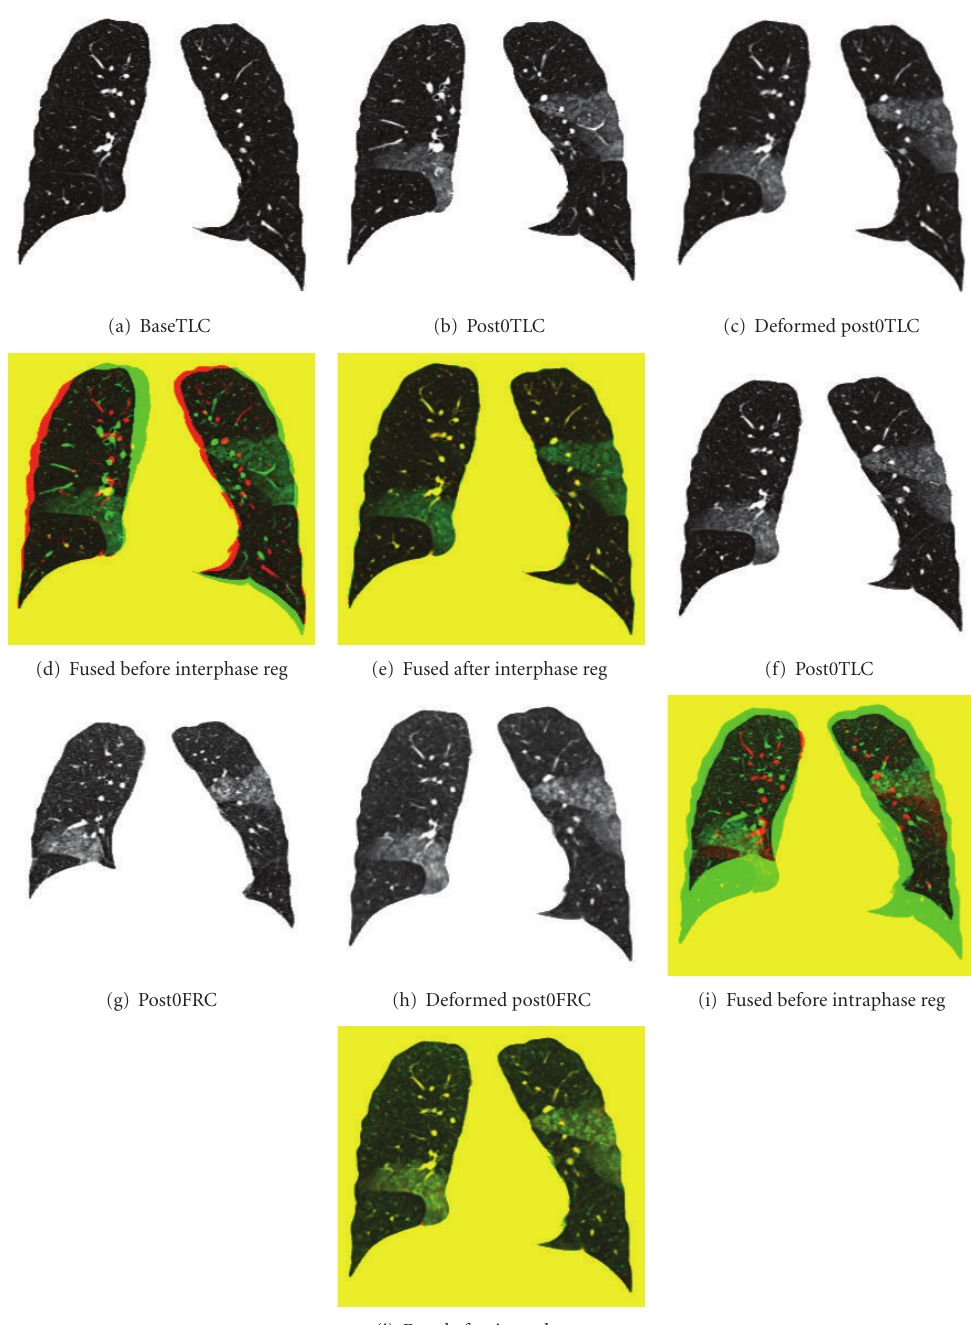
Figure 6: Example of registration results. Matching results of interphase registration: (a) a baseTLC slice; (b) a post0TLC slice; (c) the slice of deformed image from post0TLC to baseTLC which matches (a); (d) the fused slice of (a) (colored red) and (b) (colored green) before registration; (e) the fused slice of (a) and (c) after registration. Matching results of intraphase registration are shown in the same way in